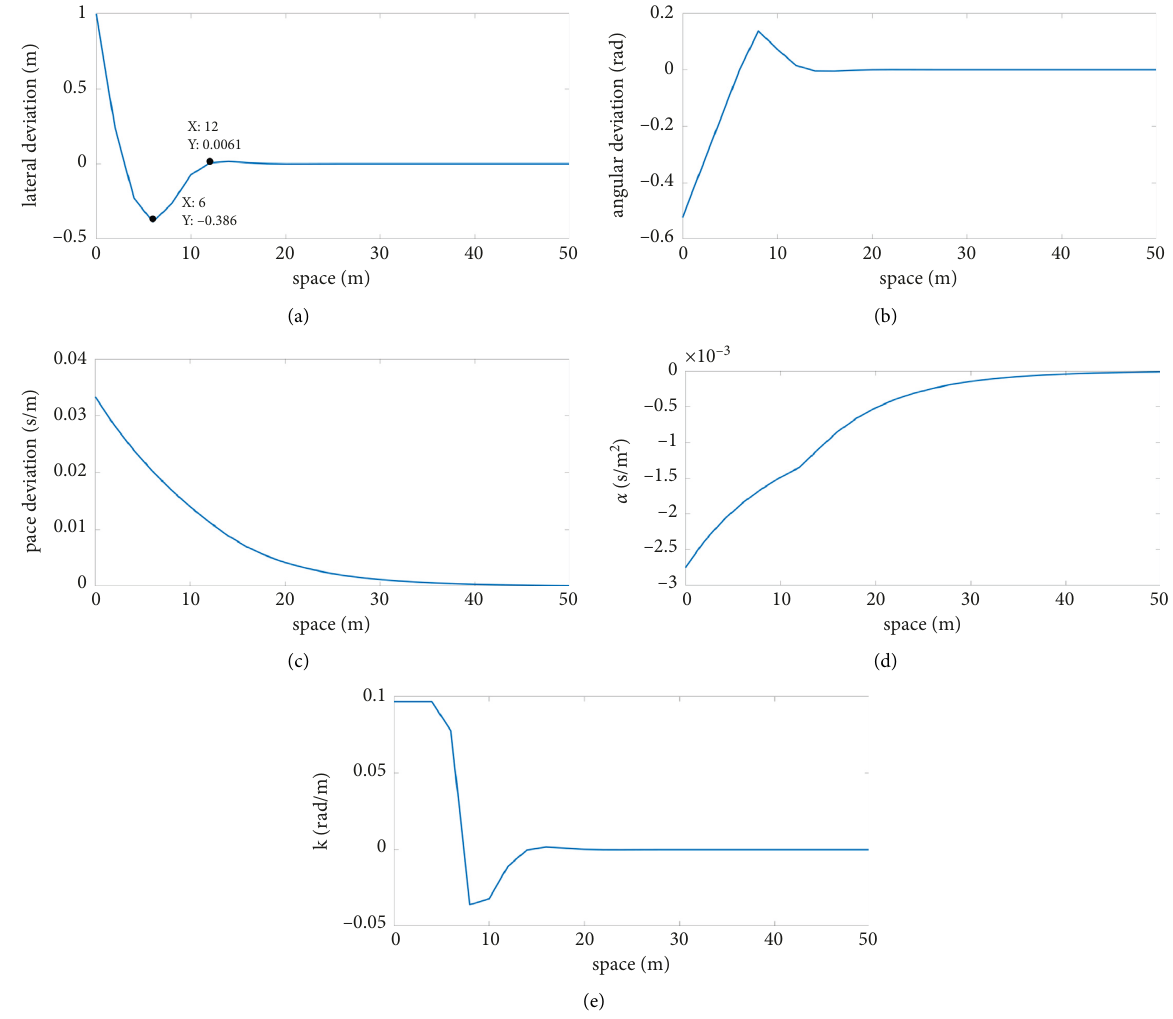
Figure 5: CAV state and control results of the first 50 meters: (a) lateral deviation r ( s ) ; (b) angular deviation ψ ( s ) ; (c) pace deviation p ( s ) ; (d) relative moderation α ( s ) ; (e) relative angular spatial change rate k ( s )